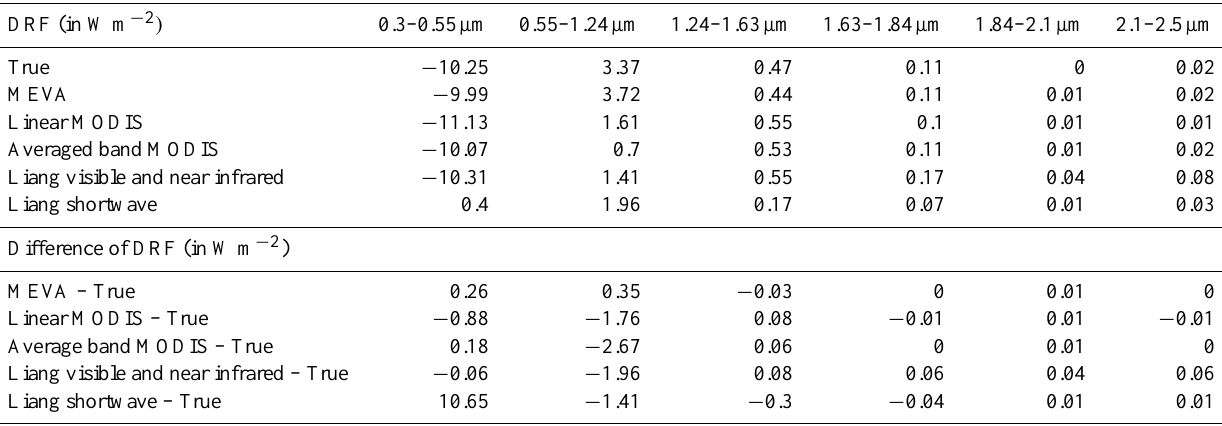
Table 3. The calculated instantaneous aerosol DRF (in Wm − 2 ) in different spectral ranges over deciduous surface. Other parameters used include: AOD (at 0.55µm)=0.32; SSA (at 0.55µm)=0.89; and SZA=30 degrees. Bold numbers represent the differences in aerosol forcing between applying specific approaches and “true” in specified spectral ranges.